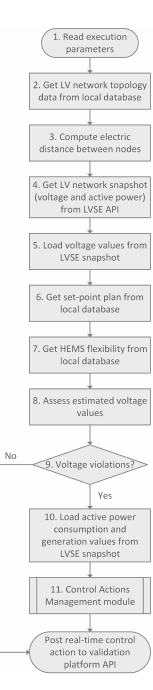
Figure 5. Real-time control module